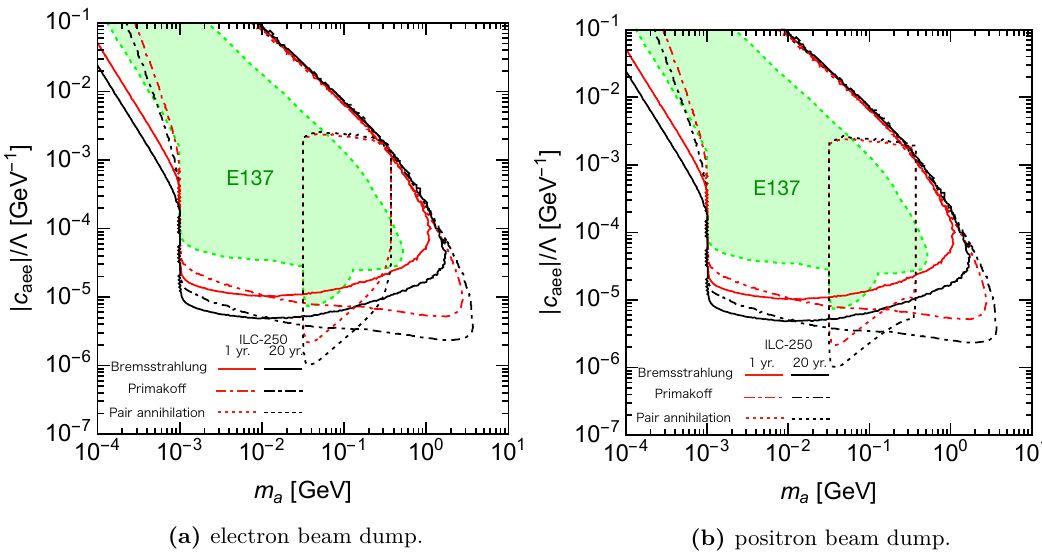
Figure 4. The result of Case I. The red and black curves show the bounds of sensitivity for ILC-250 at 95% C.L. with 1- and 20-year statistics. The solid lines are the ALP bremsstrahlung production, the dash-dotted lines are the Primakoff process, and the dotted lines the ALP production from the pair annihilation of positrons. The shaded regions are constraints from the E137 experiments.